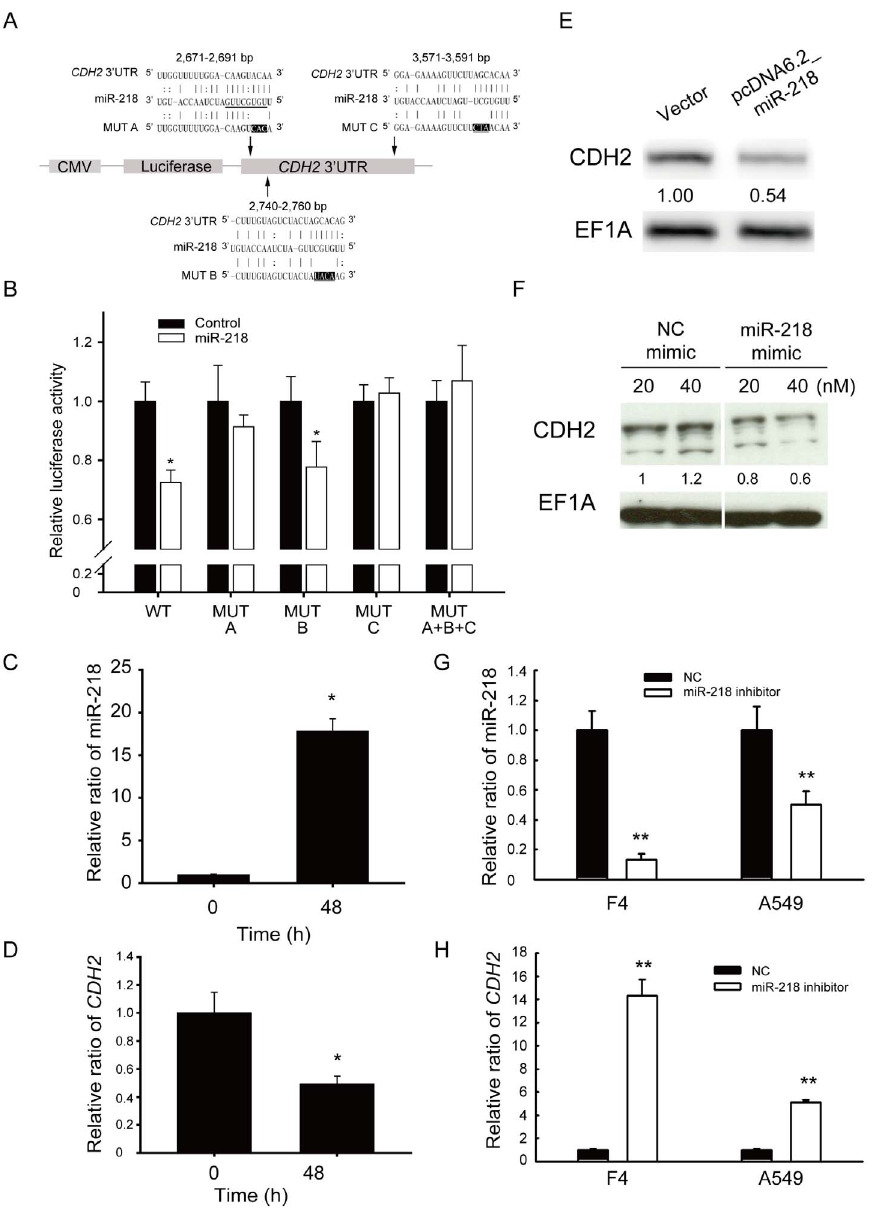
Figure 4. MiR-218 directly regulated CDH2 activity. (A) Schematic representation of miR-218 targeting the CDH2 3 9 -UTR. Firefly luciferase constructs contained the CMV promoter, luciferase coding region, and a fragment of the CDH2 3 9 -UTR. The locations of the potential miR-218 binding sites are 2,671–2,691 bp, 2,740–2,760 bp, and 3,571–3,591 bp from the transcription start site of CDH2 . (B) Luciferase assays of miR-218 binding to the CDH2 3 9 -UTR. HEK 293 cells were co-transfected with miR-218, the firefly luciferase construct and the Renilla luciferase control for the dual-luciferase assay. The relative luciferase activity represents the dual luciferase activity ratio (firefly/ Renilla luciferase). WT: wild type; MUT A, B, C: mutation at site A, B, or C, respectively; MUT A + B + C: mutation at sites A, B, and C. *, P , 0.05. (C) Relative expression levels of miR-218 in BM7 cells over-expressing pri- mir-218. The expression levels of miR-218 were detected using real-time PCR analysis at 0 and 48 h after transfection. MiR-191 was used as an internal control. (D) Relative expression levels of CDH2 in BM7 cells over-expressing pri-mir-218; 18S rRNA was used as a loading control. (E) Western blot analysis of CDH2 in BM7 cells over-expressing pri-mir-218. EF1A was used as an internal control. (F) Western blot analysis of CDH2 in BM7 cells treated with miR-218 mimic oligonucleotides. (G) Relative expression levels of miR-218 in lung cancer F4 and A549 cells transfected with negative control (NC) or miR-218 inhibitors (200 nM). The expression levels of miR-218 were detected using real-time PCR analysis at 48 h after transfection. U6B was used as an internal control. (H) Relative expression levels of CDH2 in lung cancer F4 and A549 transfected with NC or miR-218 inhibitors (200 nM); HPRT was used as internal control. **, P , 0.01.